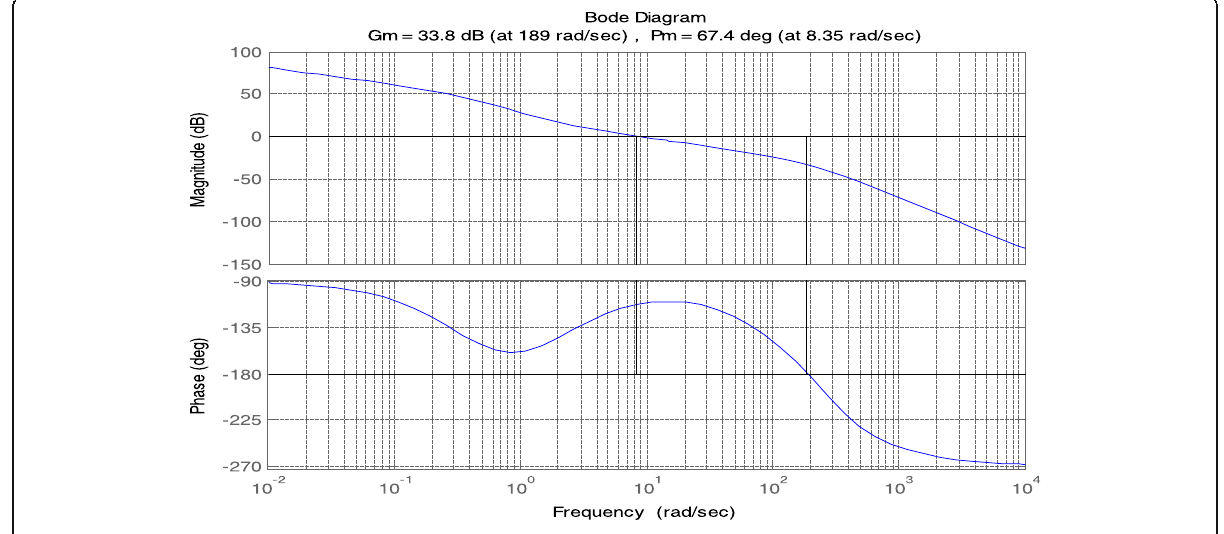
Fig. 7 Bode plot of main system position loop open loop